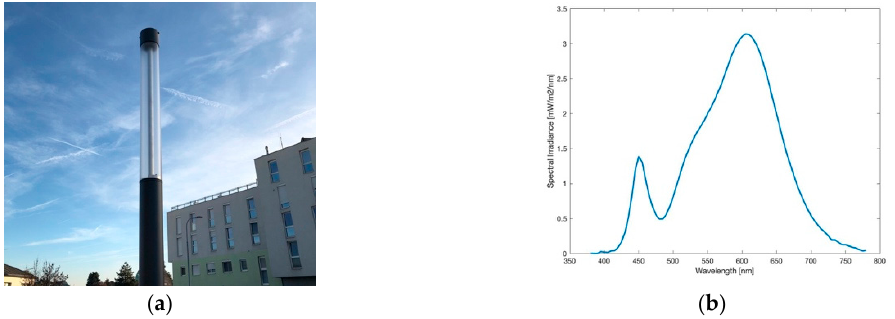
Figure 7. ( a ) Image of the tube lamp during daytime; ( b ) Spectrum of lamp observed.